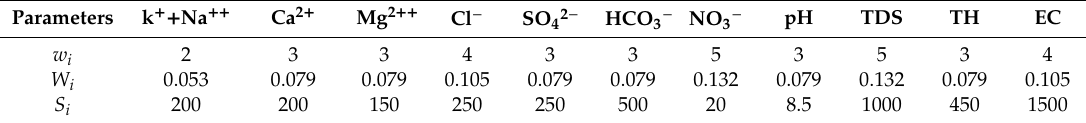
Table 1. The values of w i , W i , and S i of di ff erent parameters. TDS, total dissolved solids; TH, total hardness; EC, electrical conductivity.